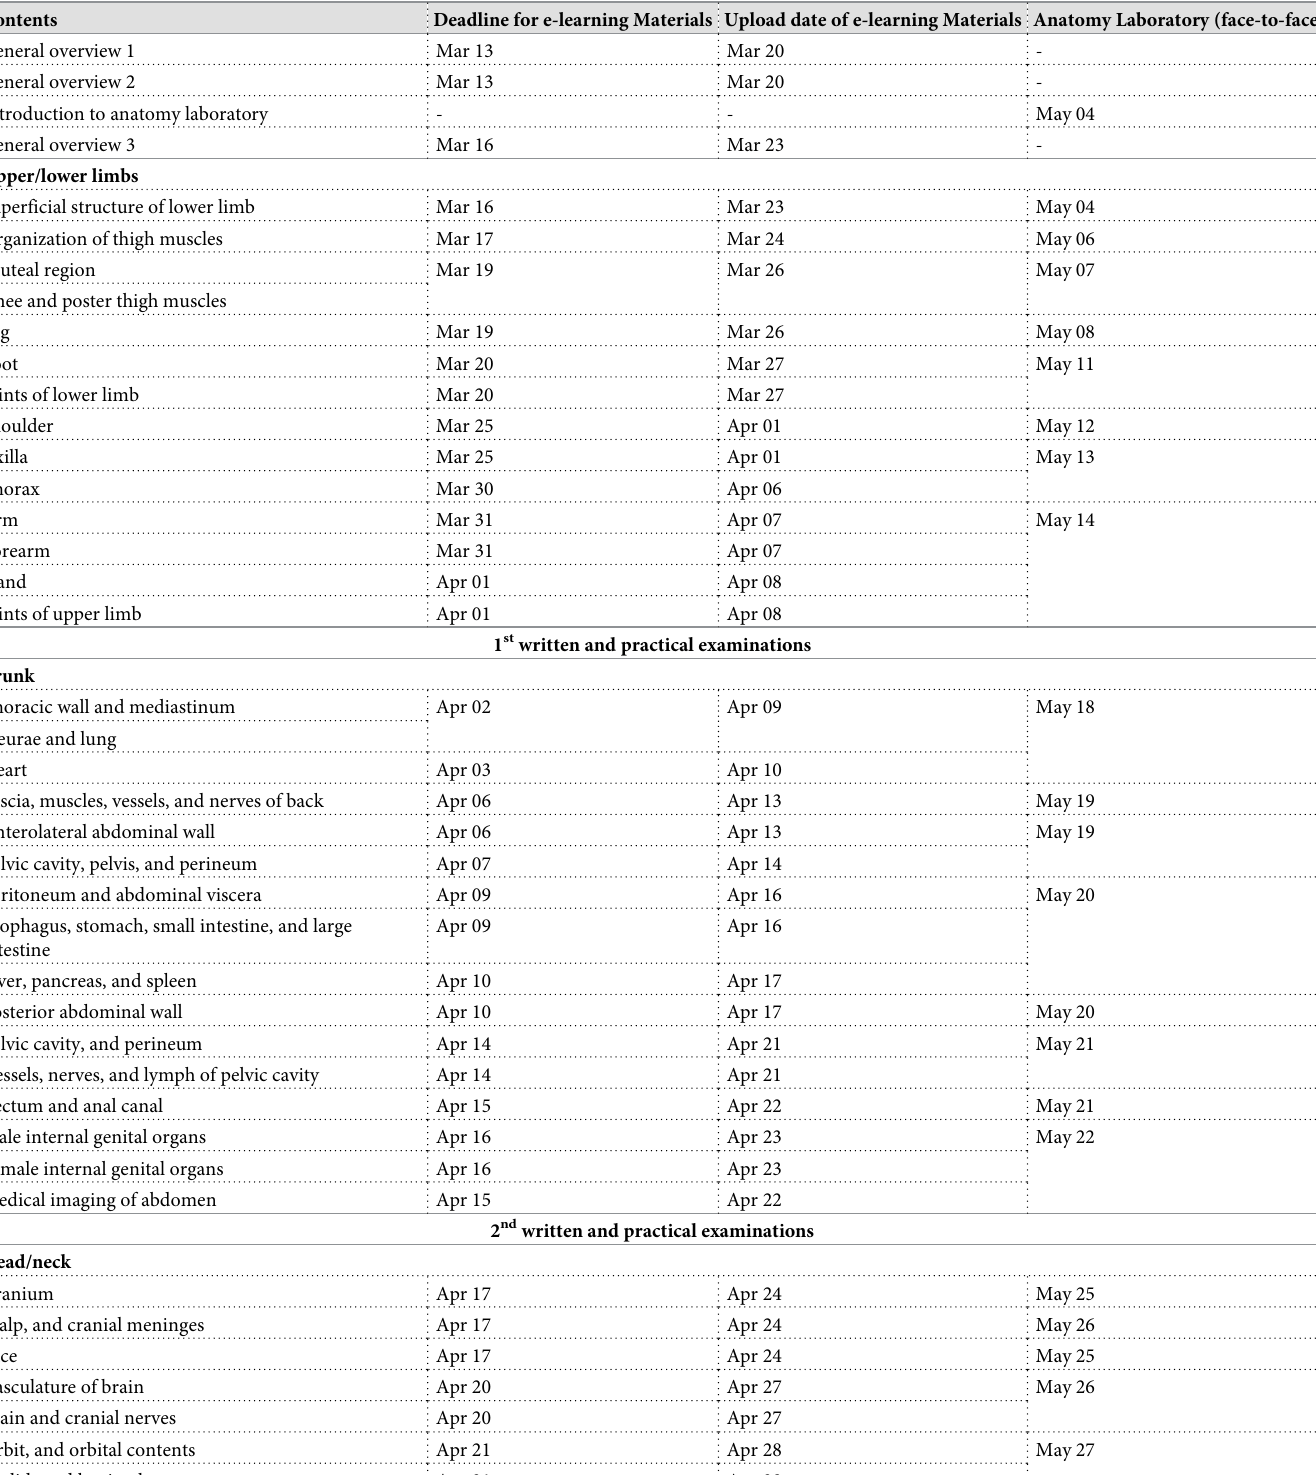
Table 1. Table of contents and schedule for the human anatomy course according to the restrictions of the COVID-19 pandemic, SNUCM,